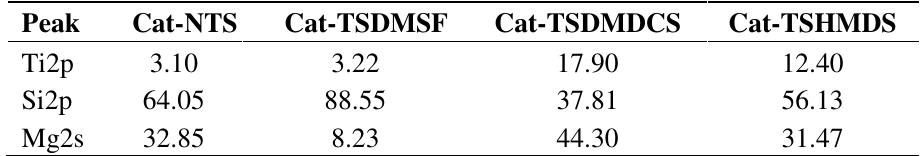
Table 2. Surface concentrations of Ti, Si and Mg in all catalysts obtained by XPS